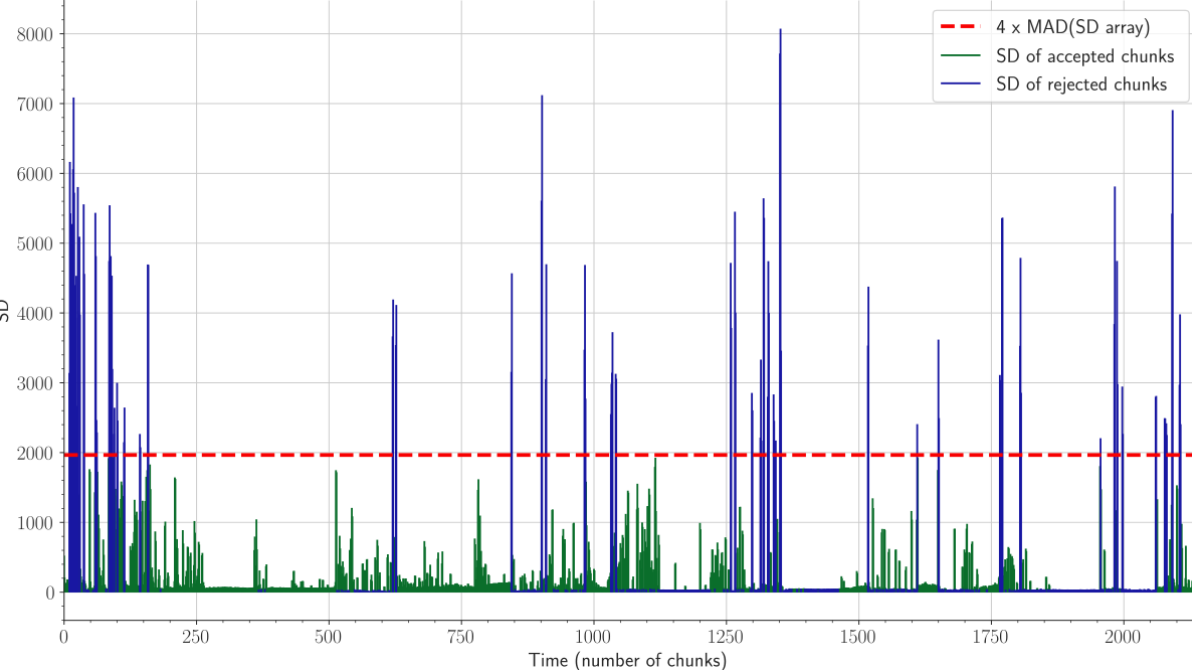
Figure 2. Illustration of isolated motion artifacts. Data chunks were suppressed if they were 4 times greater than the median absolute deviation of the SD array. MAD: median absolute